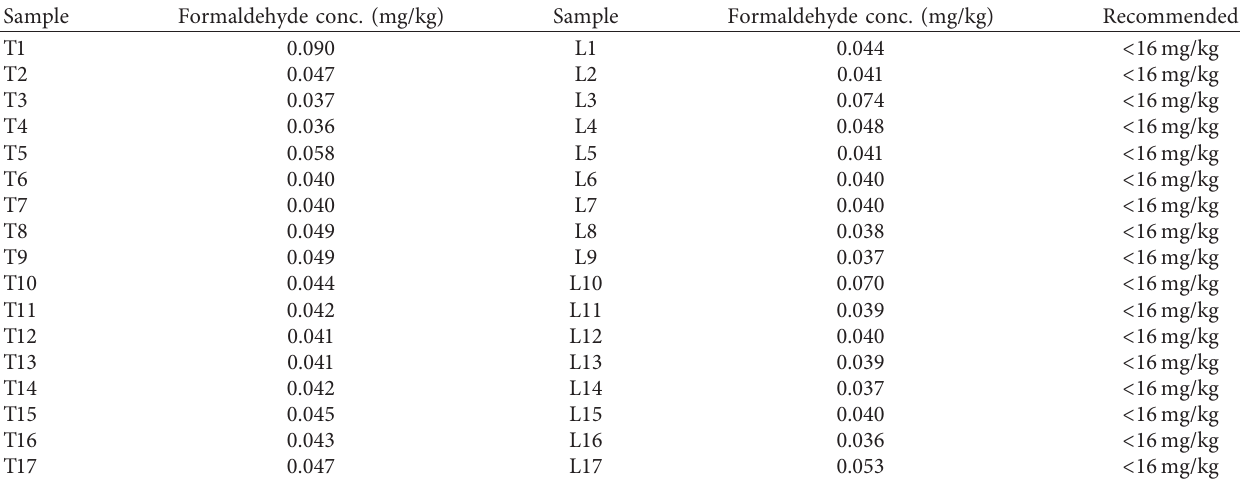
Table 4: Formaldehyde concentration in apparel purchased from high-end and low-end market stores, and the Oeko-Tex recommended values.